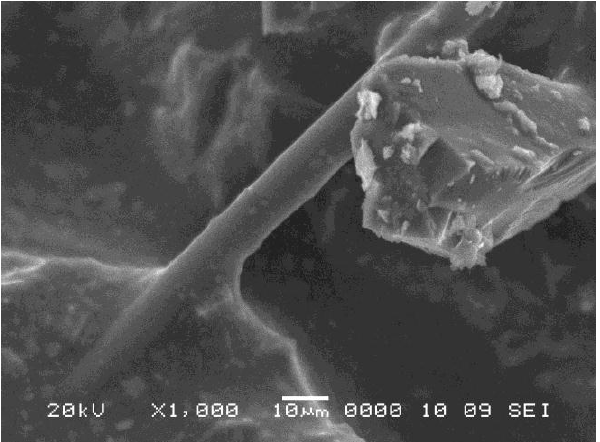
Appl. Sci. 2020 , 10 , 1561 Figure 5. The maximum bending strain of asphalt mixture containing various dosages of basalt fiber.